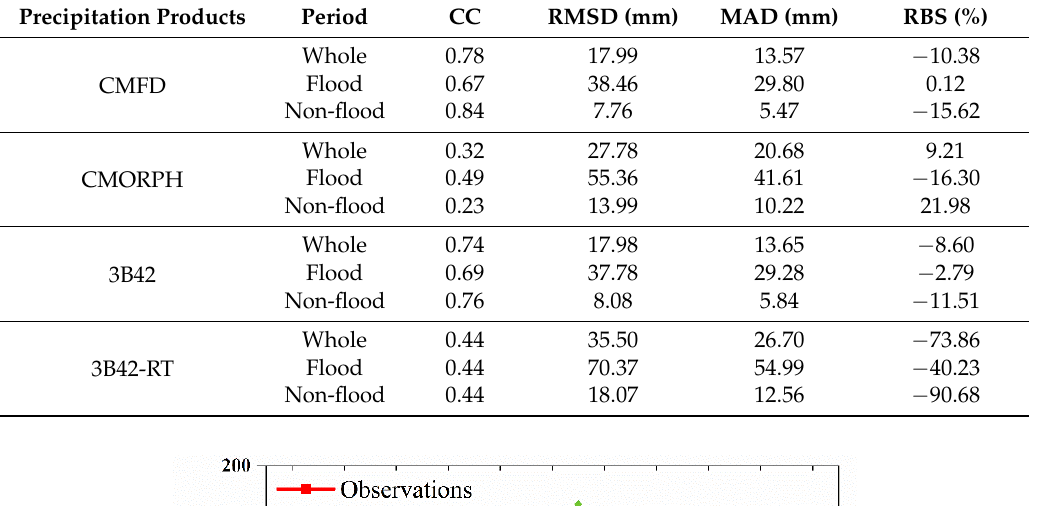
Table 5. Average monthly or seasonal statistical metrics for detection of precipitation at 36 stations in Beijing using four satellite-derived precipitation products.